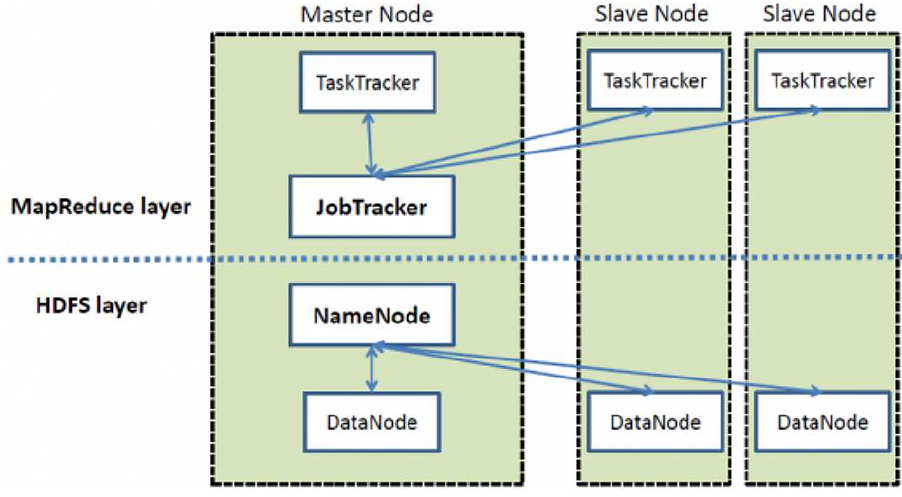
Figure 1. High level architecture of Hadoop